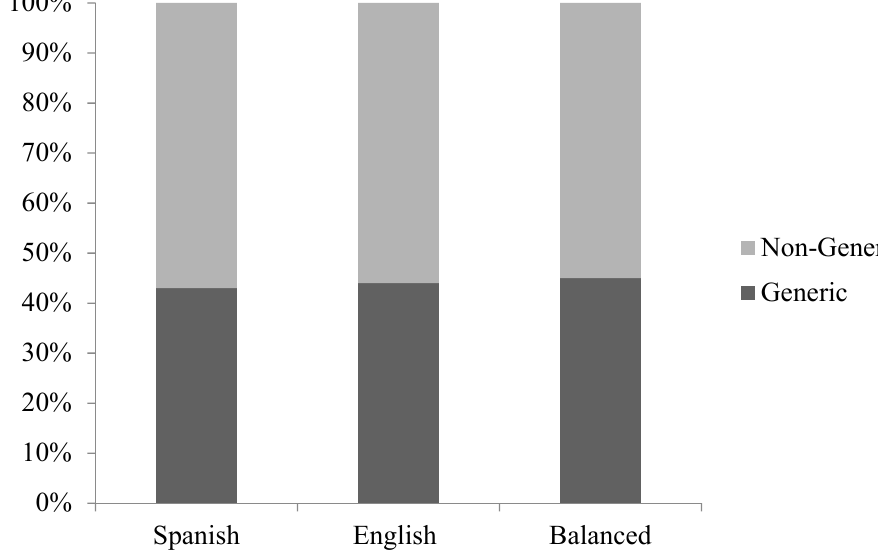
Figure 5. Interpretation of bare NPs, according to the amount of input.